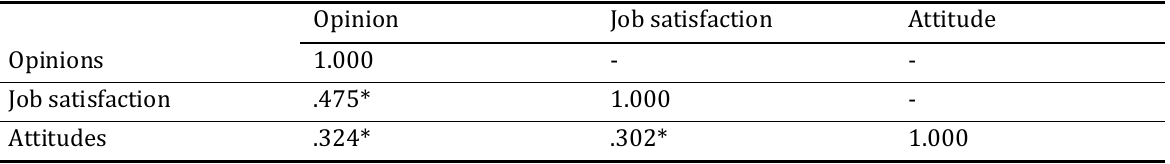
Table 6: The correlations between opinions, job satisfaction and